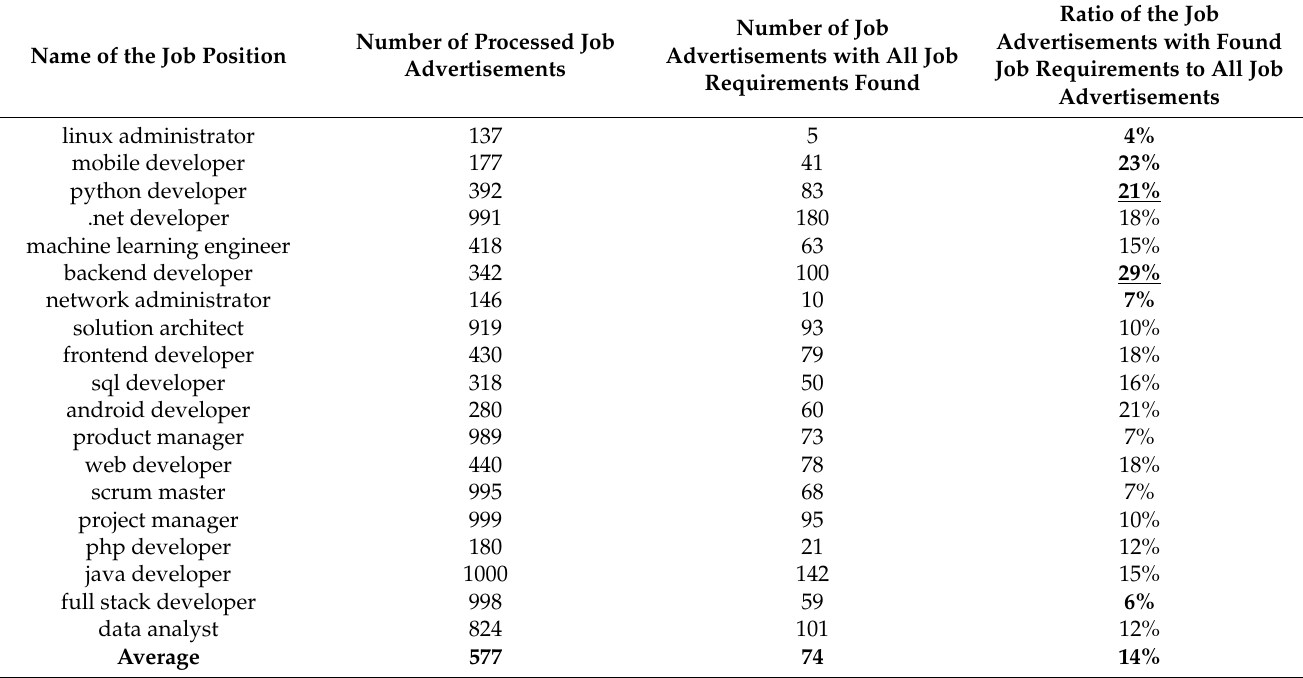
Table 3. Results of processing job advertisements using the machine with marking of sentences between positive occurrences approach.